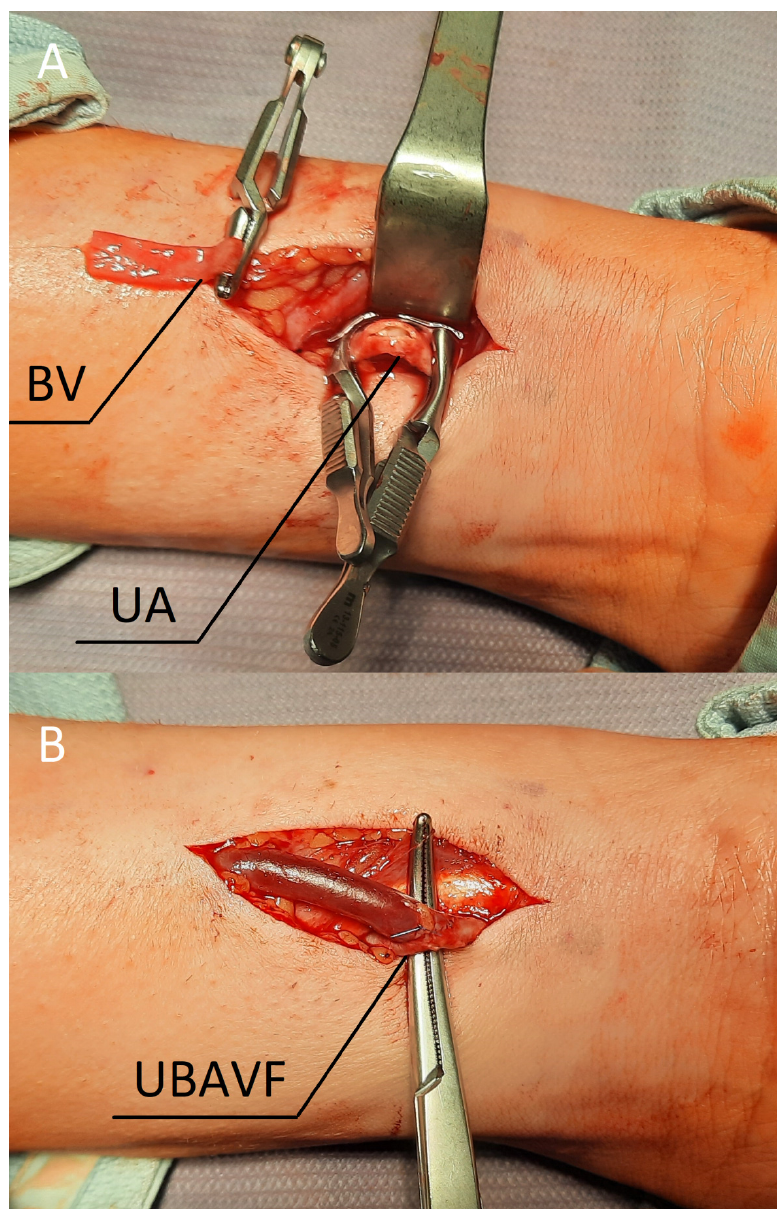
Figure 2. ( A ) Dissected vessels prepared for anastomosis. ( B ) The ulnar-basilic arteriovenous fistula after releasing the clamps. Abbreviations: UA—ulnar artery, BV—basilic vein, UBAVF—ulnar-basilic arteriovenous